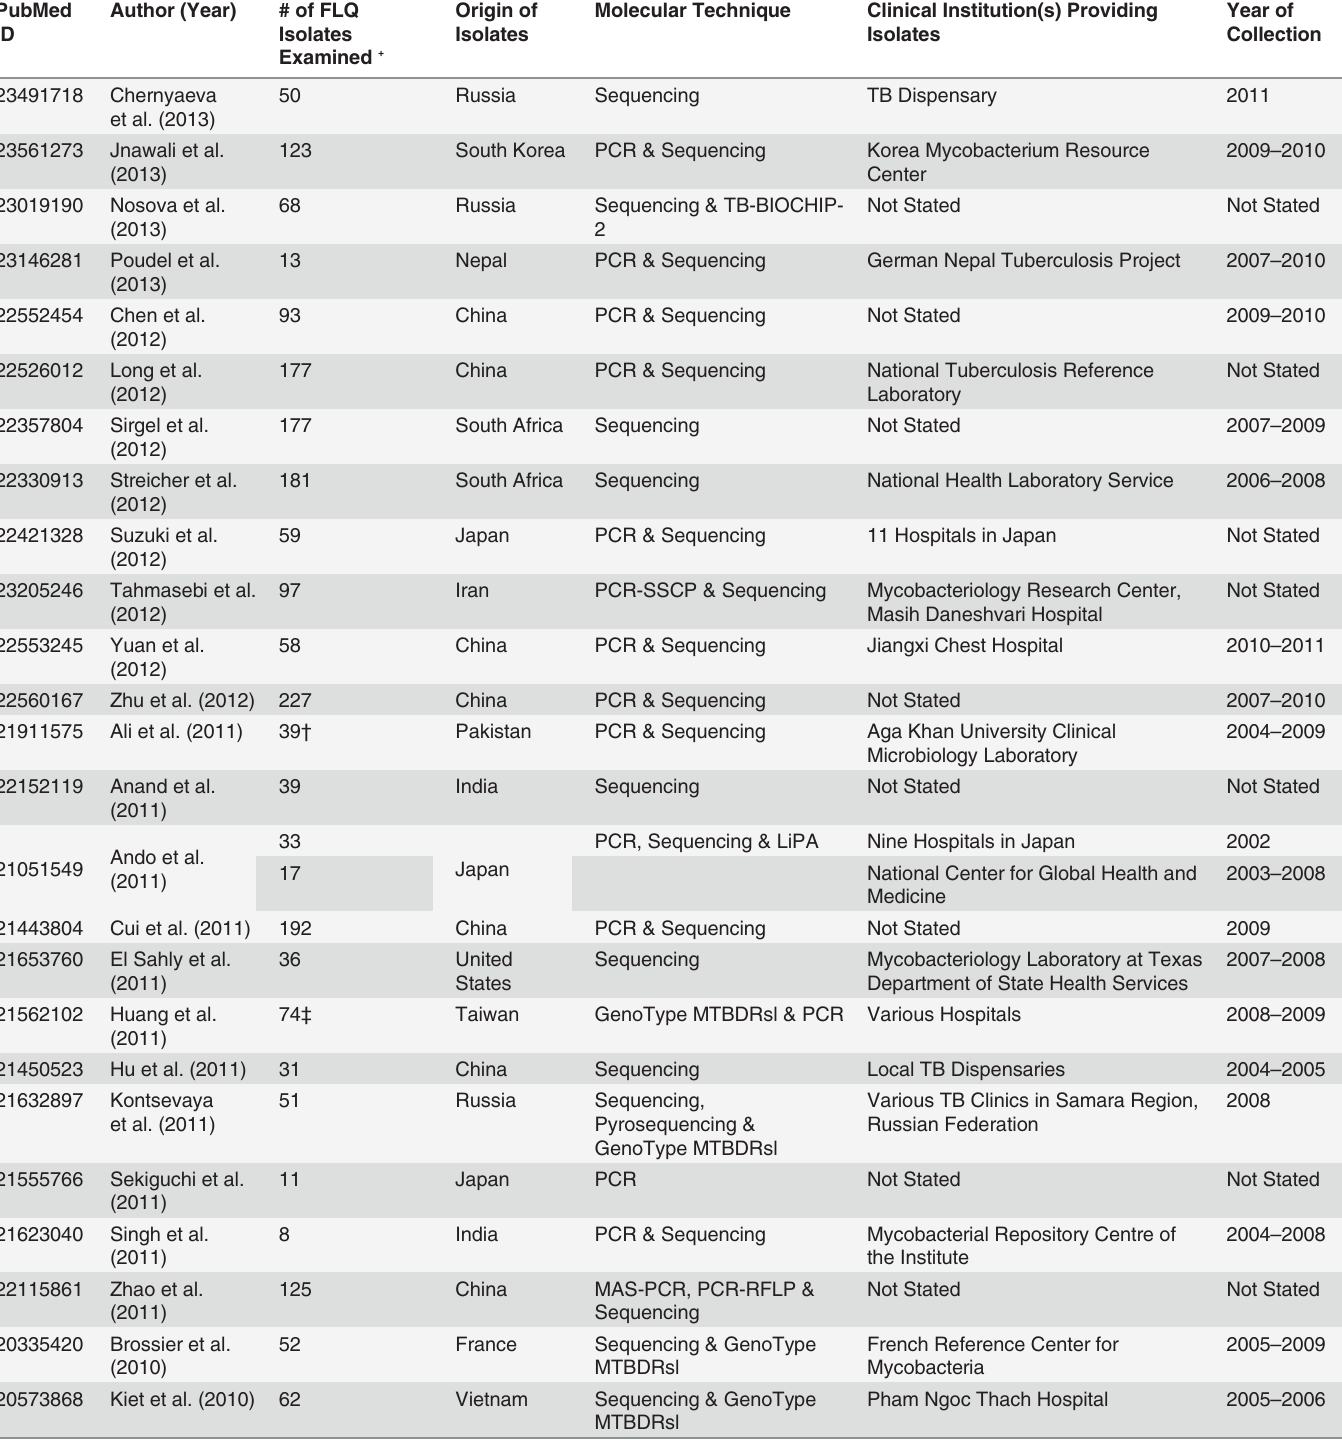
Table 1. Details of Studies Included in Review and Source of Mycobacterium tuberculosis